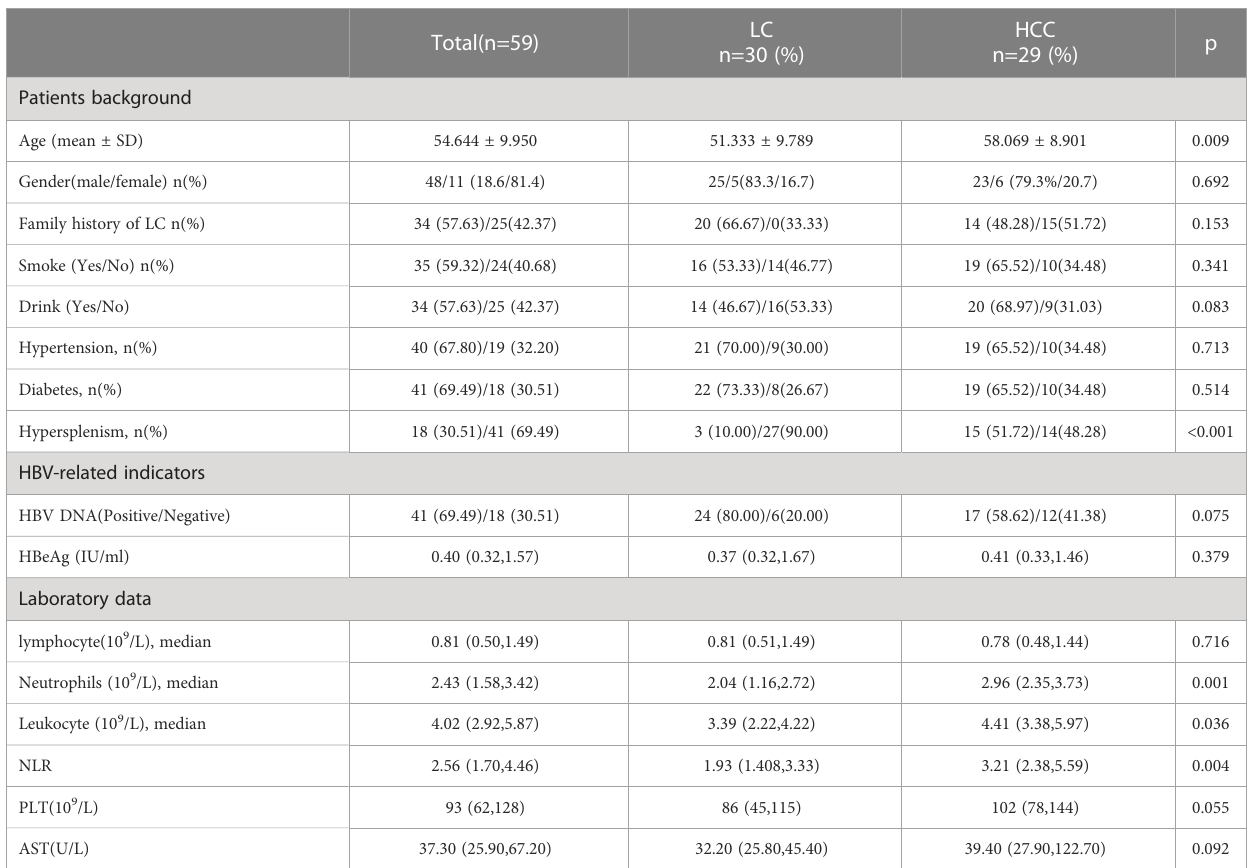
TABLE 1 Demographic and clinical characteristics of patients with HBV-LC,